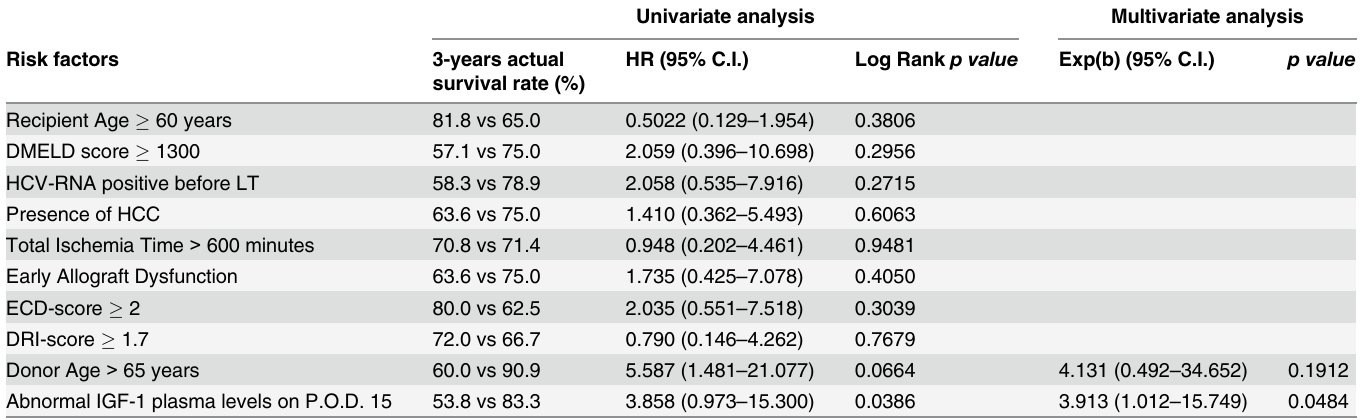
Table 3. Univariate and multivariate analysis of risk factors affecting patient survival. IGF-1, insulin-like growth factor 1; LT, liver transplantation; ECD, extended criteria donor; DMELD, donor age x Model for End Stage Liver Disease; EAD, early allograft dysfunction; DRI, Donor Risk Index; HCV, hepatitis C virus; HCC, hepatocellular carcinoma; POD, postoperative